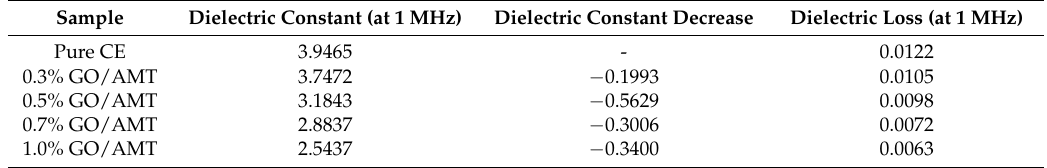
Table 3. Dielectric properties of GO/AMT-CE composites with different GO/AMT contents.